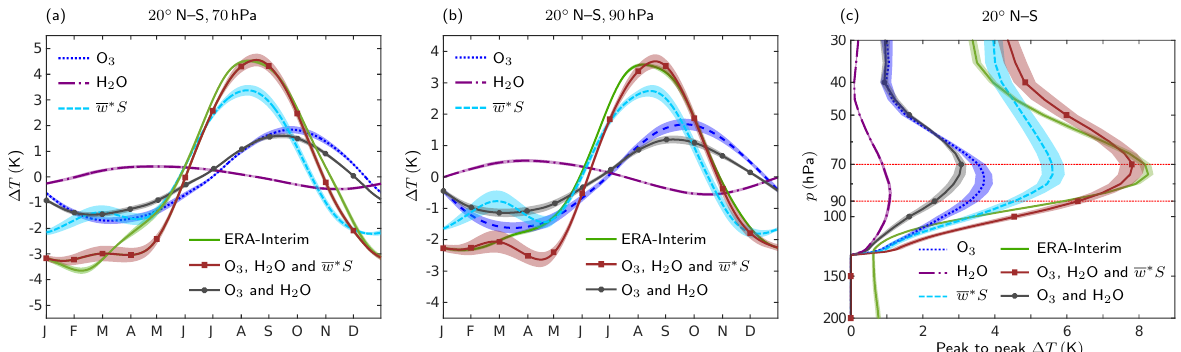
Figure 7. Temperature changes (K) calculated using the SEFDH method with annual cycles in ozone and water vapour and from the modified SEFDH method (Sect. 4) for the dynamical heating. The plots are averaged between 20 ◦ N and 20 ◦ S at (a) 70hPa and (b) 90hPa. The ERA- Interim annual temperature cycle is also shown. Note that the vertical axes are different in (a, b) . (c) The peak-to-peak amplitude of the temperature change averaged between 20 ◦ N and 20 ◦ S. Note that there is a phase difference between the temperature from the annual water vapour and ozone cycles. Shadings show 95% confidence intervals arising from uncertainties in the datasets (see Appendix B for more